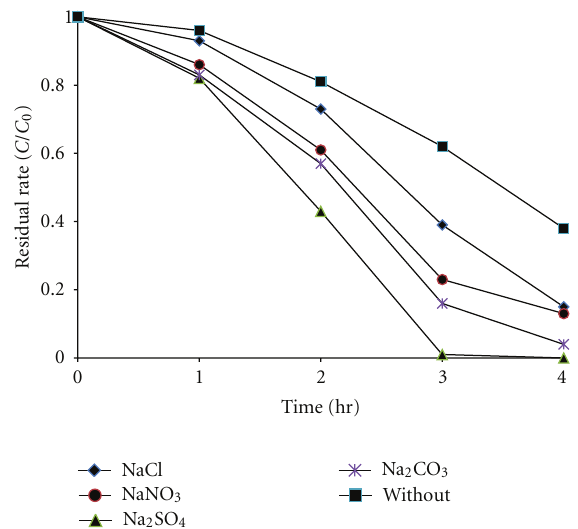
Figure 8: Residual rates of sodium oxalate under photoelectrocat- alytic reactions with di ff erent